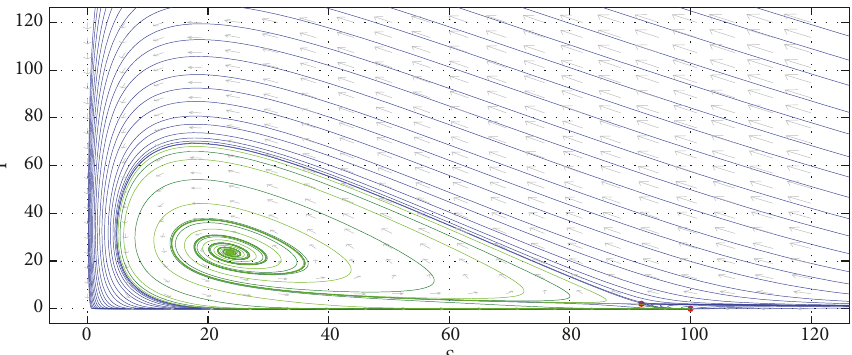
Figure 18: Phase portrait when there is a stable endemic equilibrium surrounded by an unstable limit cycle. The other endemic equilibrium is a saddle and the DFE is a stable node.